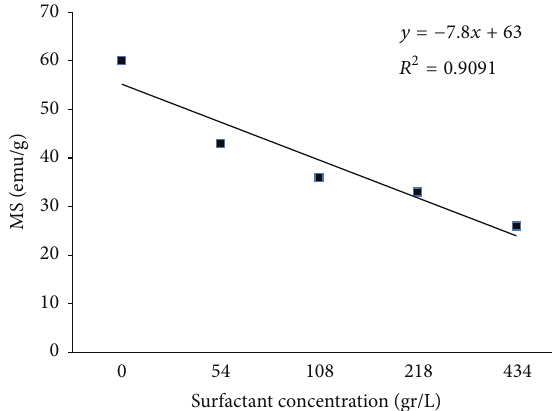
Figure 6: Magnetite saturation of synthesize Fe 3 O 4 particles with various amounts of